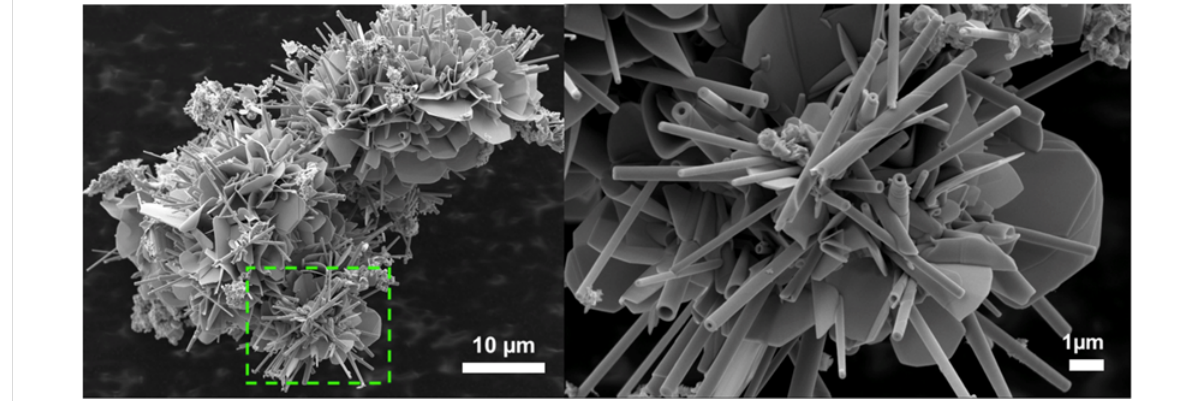
Figure 1: SEM images (two different magnifications) of La x Sr 1 − x S − TaS 2 powder prepared from 10 atom % Sr (90 atom % La) in the precursor. Tubular structures and conical nanoscrolls along with sheet-like morphology are visible.